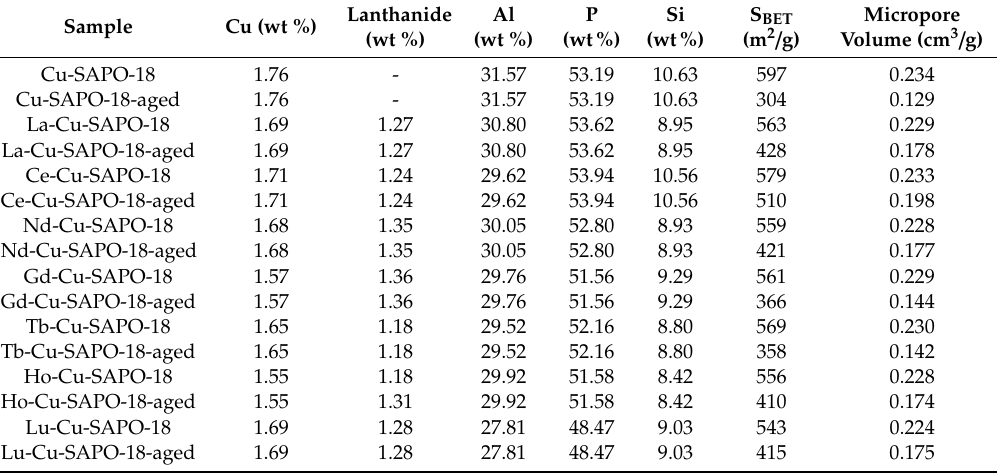
Table 1. Chemical Compositions and BET Surface Areas of the Cu-SAPO-18 and M-Cu-SAPO-18